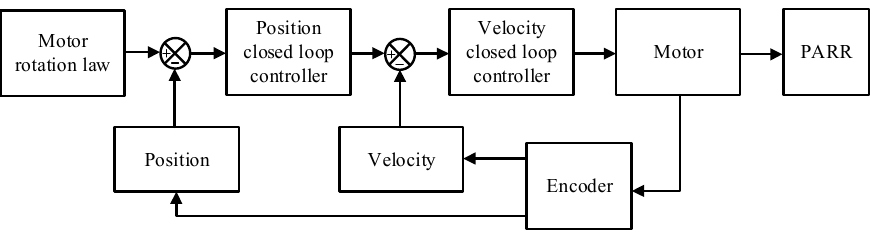
Figure 11. The control strategy.